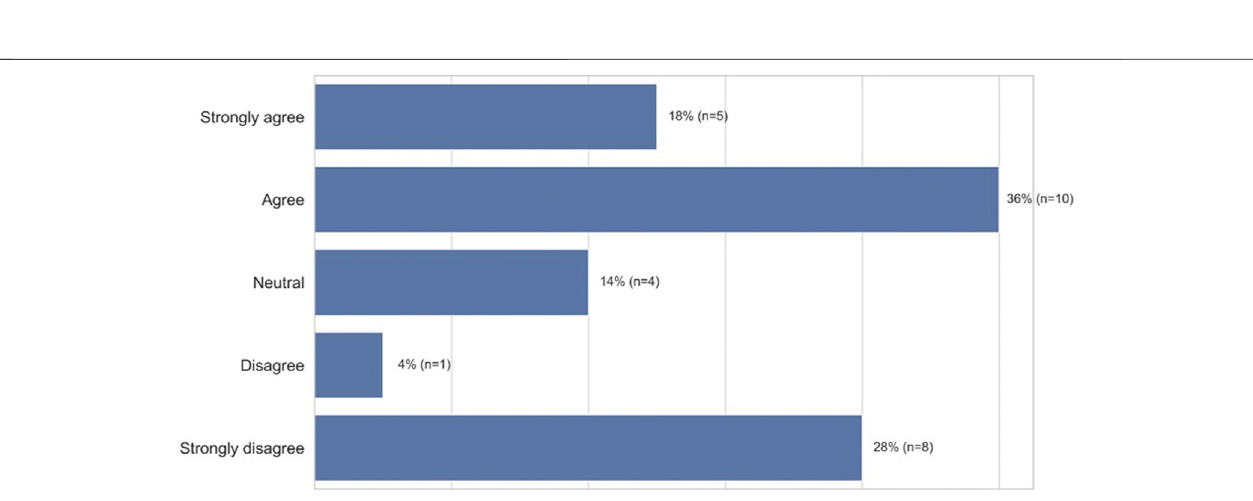
FIGURE 10 | African-American participants needed to modify their speech for different results ( n (cid:1) 28).